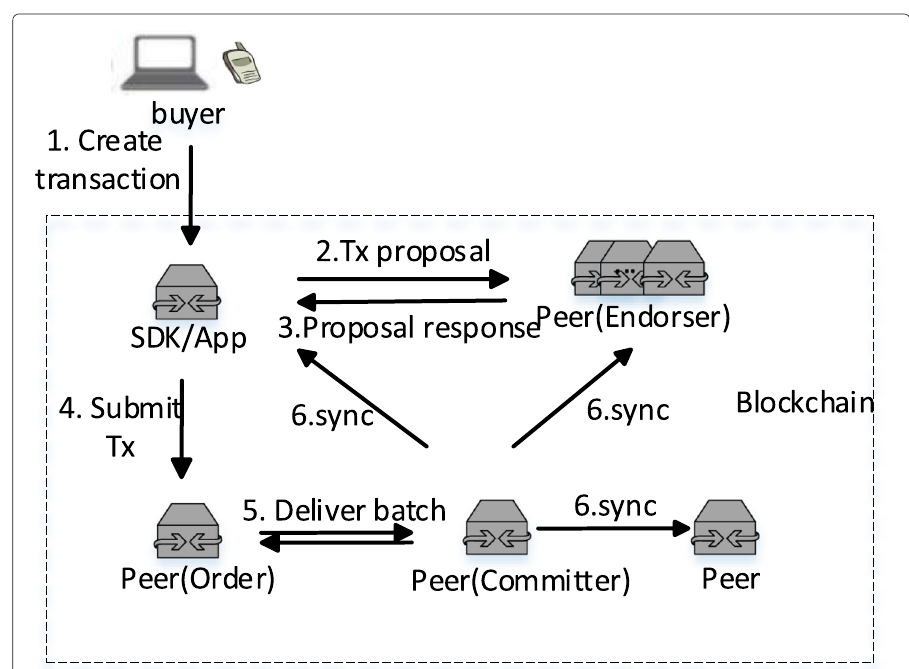
Fig. 4 Process of writing transaction into the global